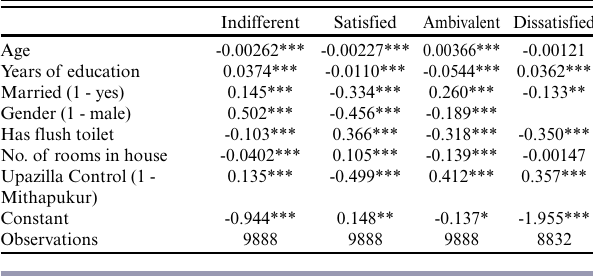
Table 1 . Coefficients for probit models predicting membership of each of the satisfaction groups (against baseline of